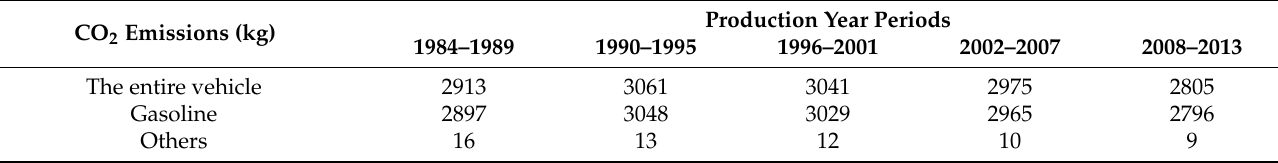
Table 7. Average CO 2 emissions in kg for different production